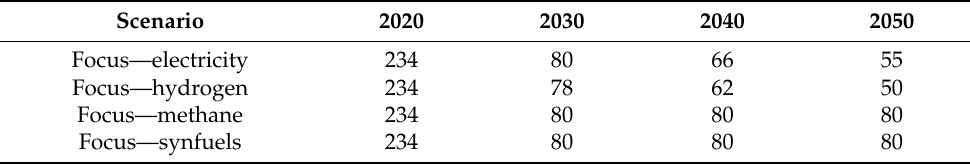
Table 6. Fuel cell prices ( € /kW). Own assumptions based on refs.